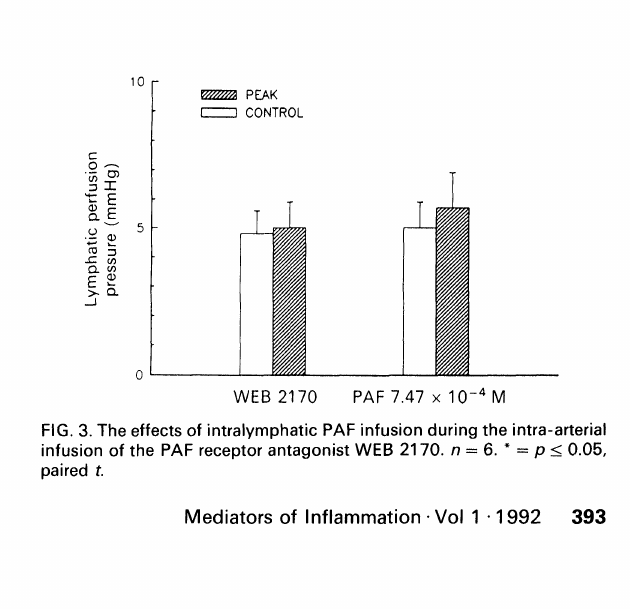
FIG. 2. The effects of intralymphatic PAF infusion during the intra-arterial infusion of phentolamine, n 6. p _< 0.05, paired